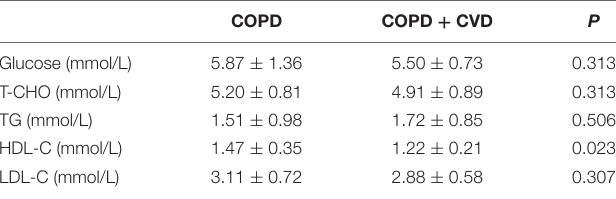
TABLE 4 | The glucose and lipids between two groups.